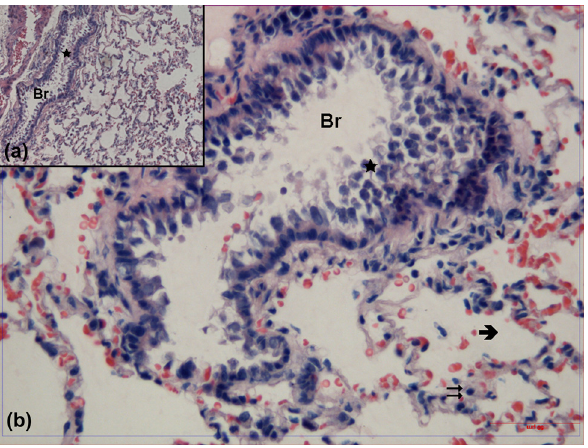
Figure 2: Hematoxylin – eosin - stained lung tissue samples obtained from the group treated with physiological saline. Br: bronchioles, (cid:2) : alveoli, (cid:3) : interalveolar septa, (cid:2) : cell debris ( hematoxylin – eosin, A: × 100, B: × 400 ) .